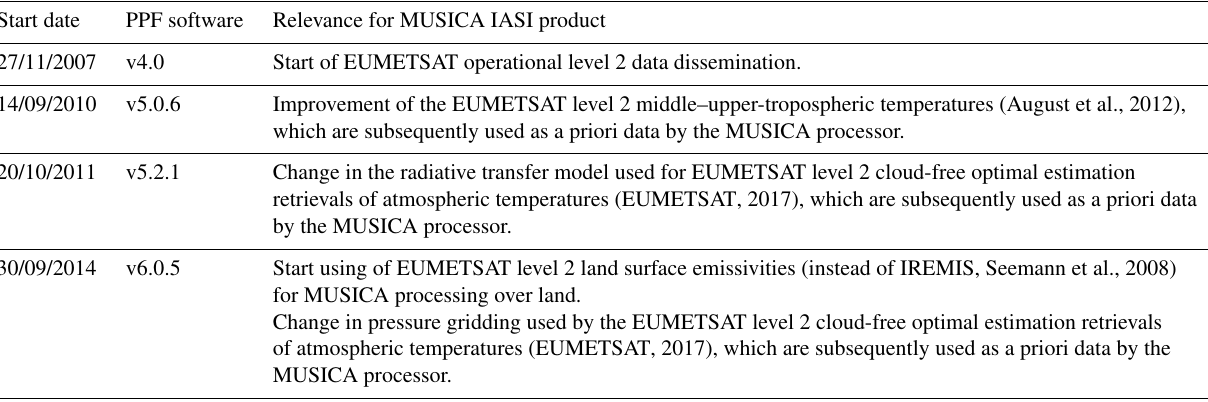
Table 1. History of EUMETSAT level 2 PPF software modification and EUMETSAT level 2 data usage that can potentially affect the MUSICA IASI products.